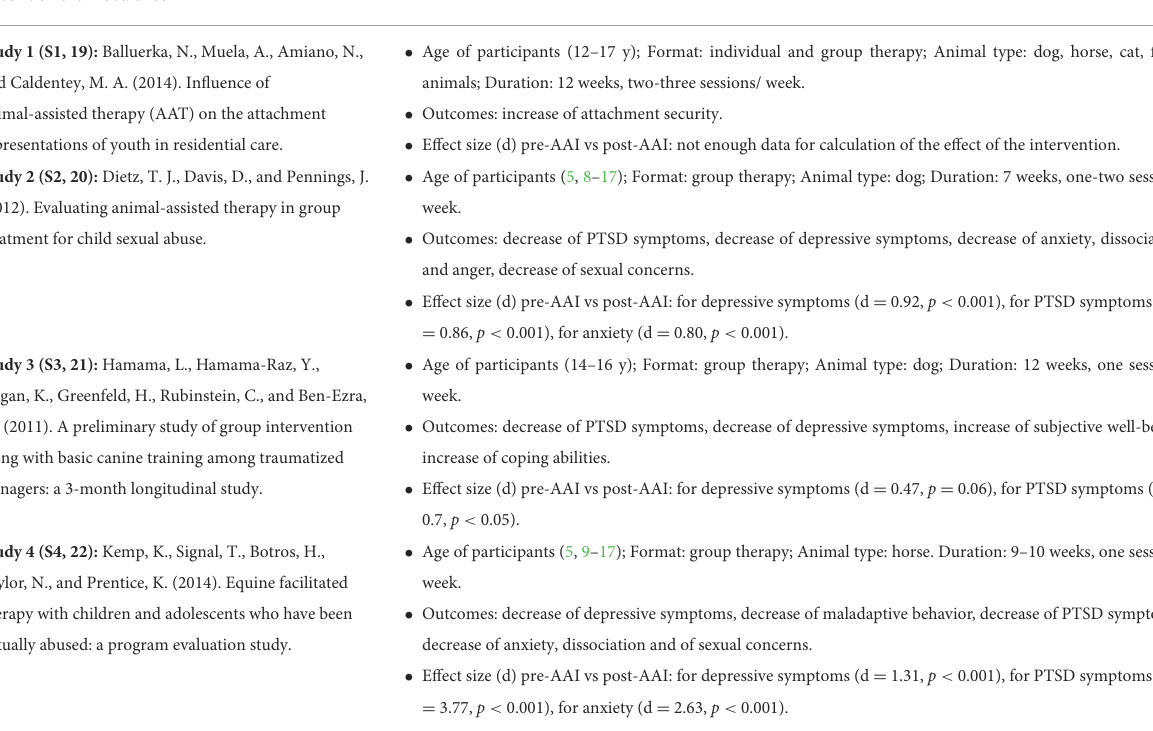
TABLE 1 The characteristics of the four AAI-group intervention studies included in the meta-analysis of O’Haire et al.